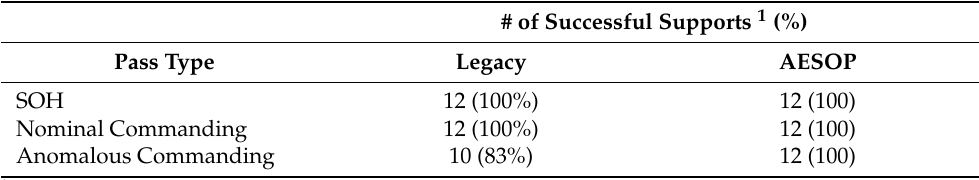
Table 3. Number of Successful Supports with Each HMI. # of Successful Supports 1 (%) Pass Type Legacy